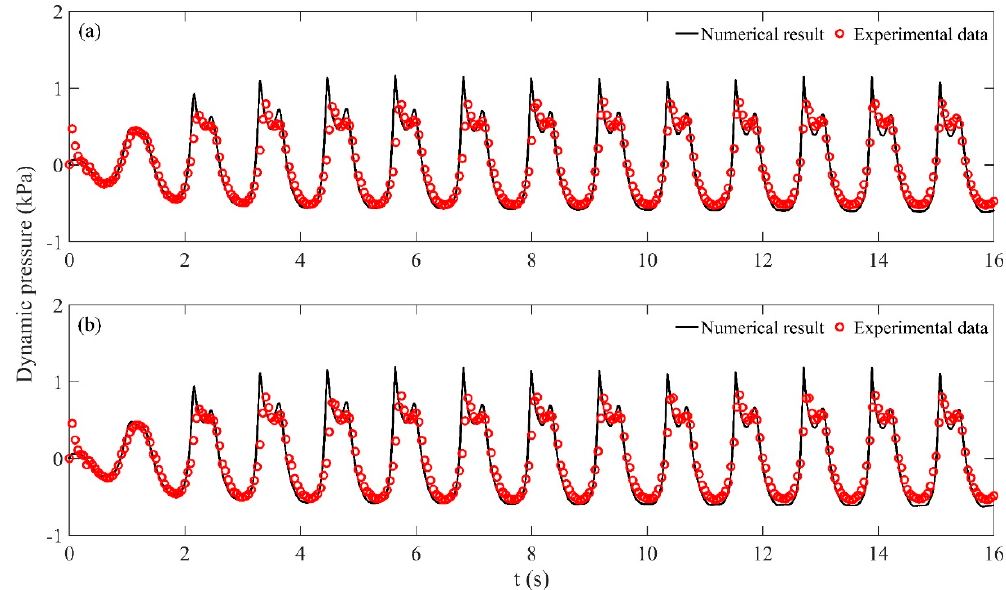
tank walls. Overall, the di ff erence between the two results is negligible.